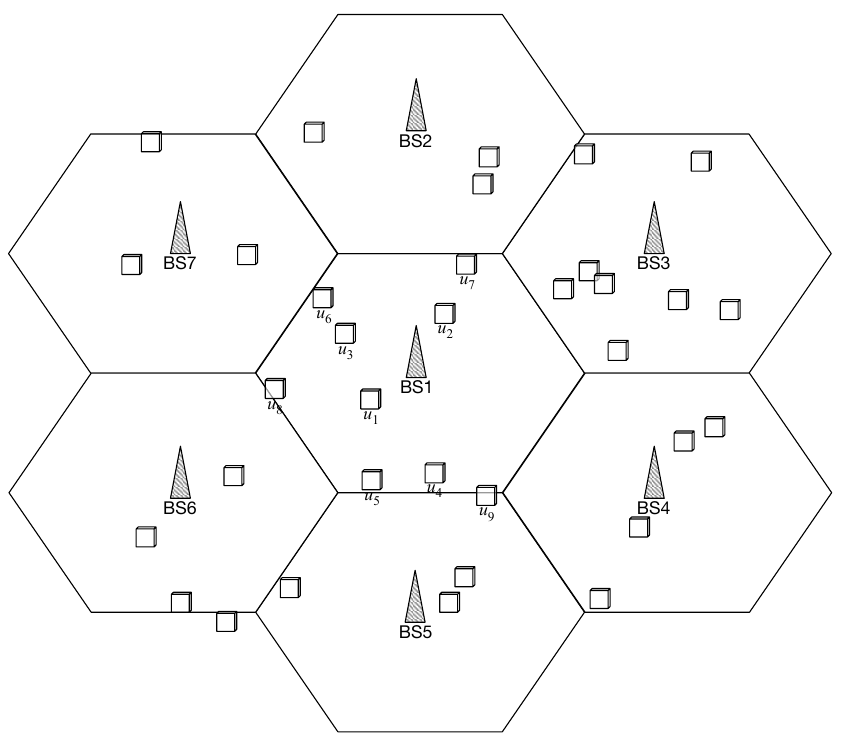
Figure 2. Simulation